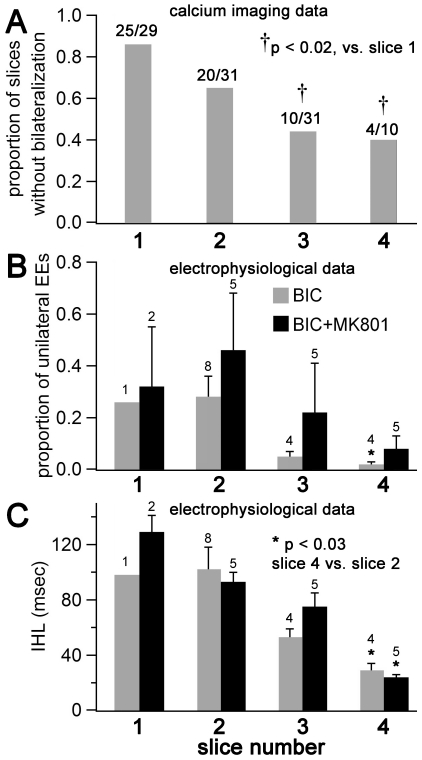
Differences in bilateral epileptiform activity according to rostral-caudal coordinates of the slice within ACC.Recordings are grouped according to slice number, where each slice increment represents a 350 µm increment caudally from the most rostral part of the corpus callosum, and slice 1 is the first slice to show an intact callosum as slices are taken from rostral to caudal. (A) Calcium imaging data from a total of 101 slices, each recorded for approximately 2 minutes. Proportions of slices that yielded no evidence of bilateralization are shown (i.e., no cells recorded in separate hemispheres with simultaneous calcium transients). The caudal slices were more likely to demonstrate bilateral EEs. (B) and (C) Data from 30–60 minute-long long extracellular electrophysiological recordings. For the BIC group (20 µM bicuculline), n = 1, 8, 4, and 4 for slices 1–4, respectively, while for the BIC+MK801 group (20 µM bicuculline+10 µM MK-801), n = 2, 5, 5, and 5 for slices 1–4, respectively. (B) The proportion of unilateral EEs in each recording is smaller for caudal slices than rostral slices within ACC. For the BIC group, there is a significant difference in these values between the slice 4 and slice 2 groups. Note a similar trend in the BIC+MK801 group. (C) The interhemispheric latencies (IHLs) are shorter for caudal slices than in rostral slices, for both the BIC and BIC+MK801 groups.